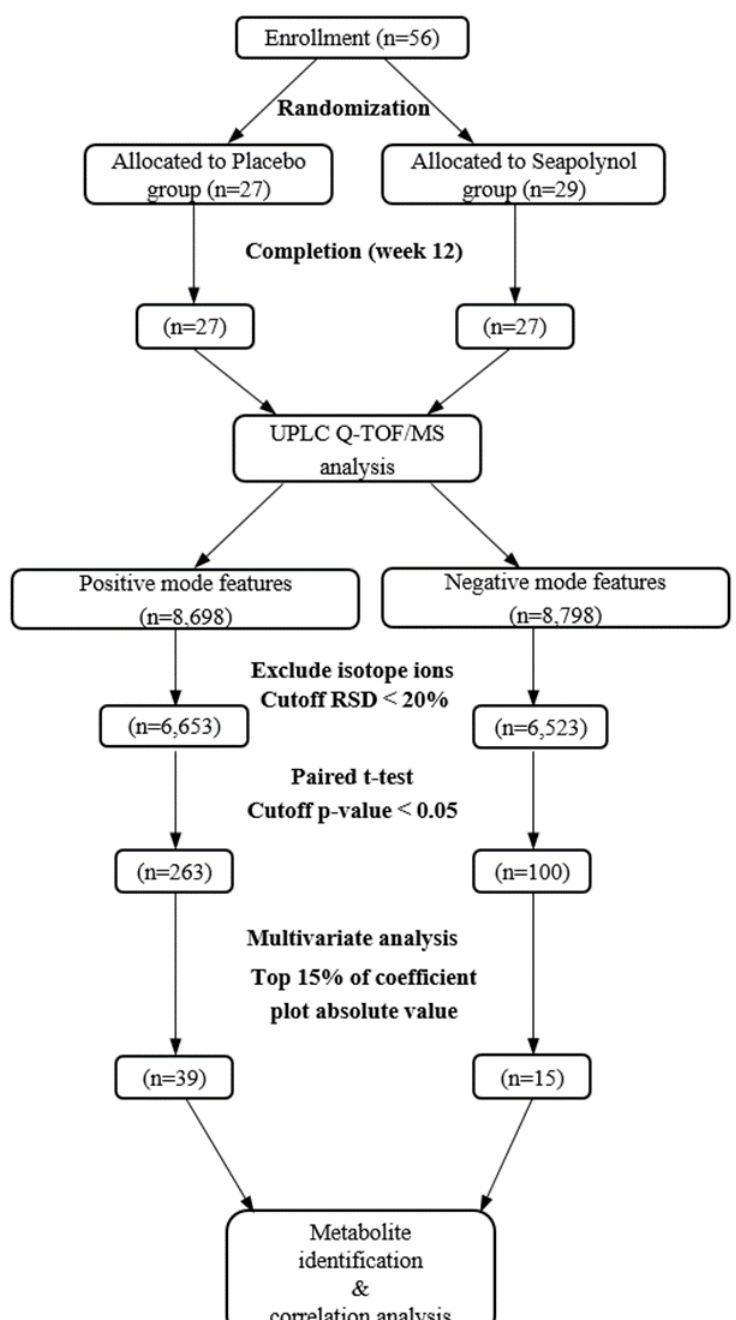
Figure 1. Flow diagram of the study design.